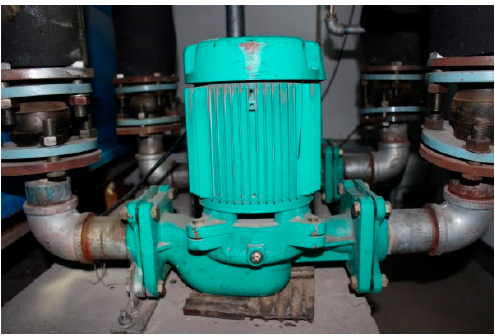
Figure 5. A circulating water pump without vibration reduction treatment.